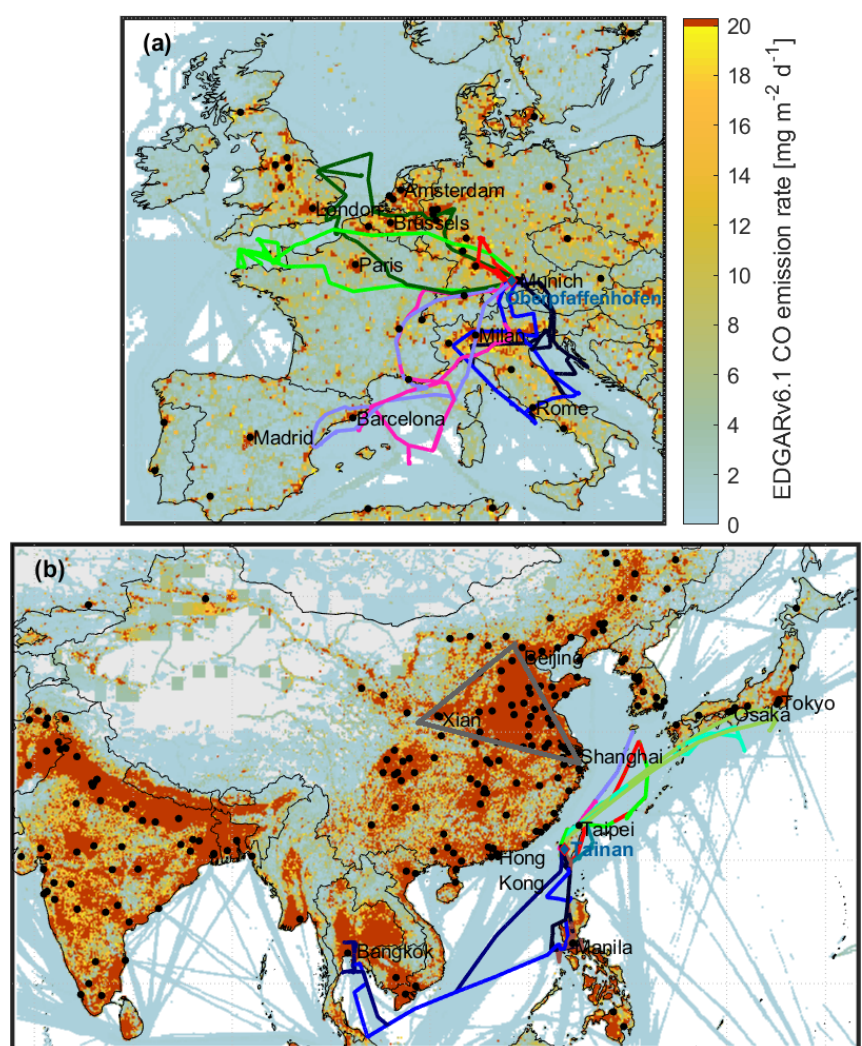
Figure 2. CO emission rates from anthropogenic sources (EDGAR v6.1 Global Air Pollutant Emissions, year 2018, monthly means), (a) Europe: July (EMeRGe-Europe), (b) Asia: March (EMeRGe-Asia) and EMeRGe flight tracks (blue lines). Black dots mark cities with more than one million inhabitants. Grey triangle in (b) marks the megacity agglomeration between the cities Xian, Beijing and Shanghai. For clarity, emission rates below 0.01mgm − 2 d − 1 are not